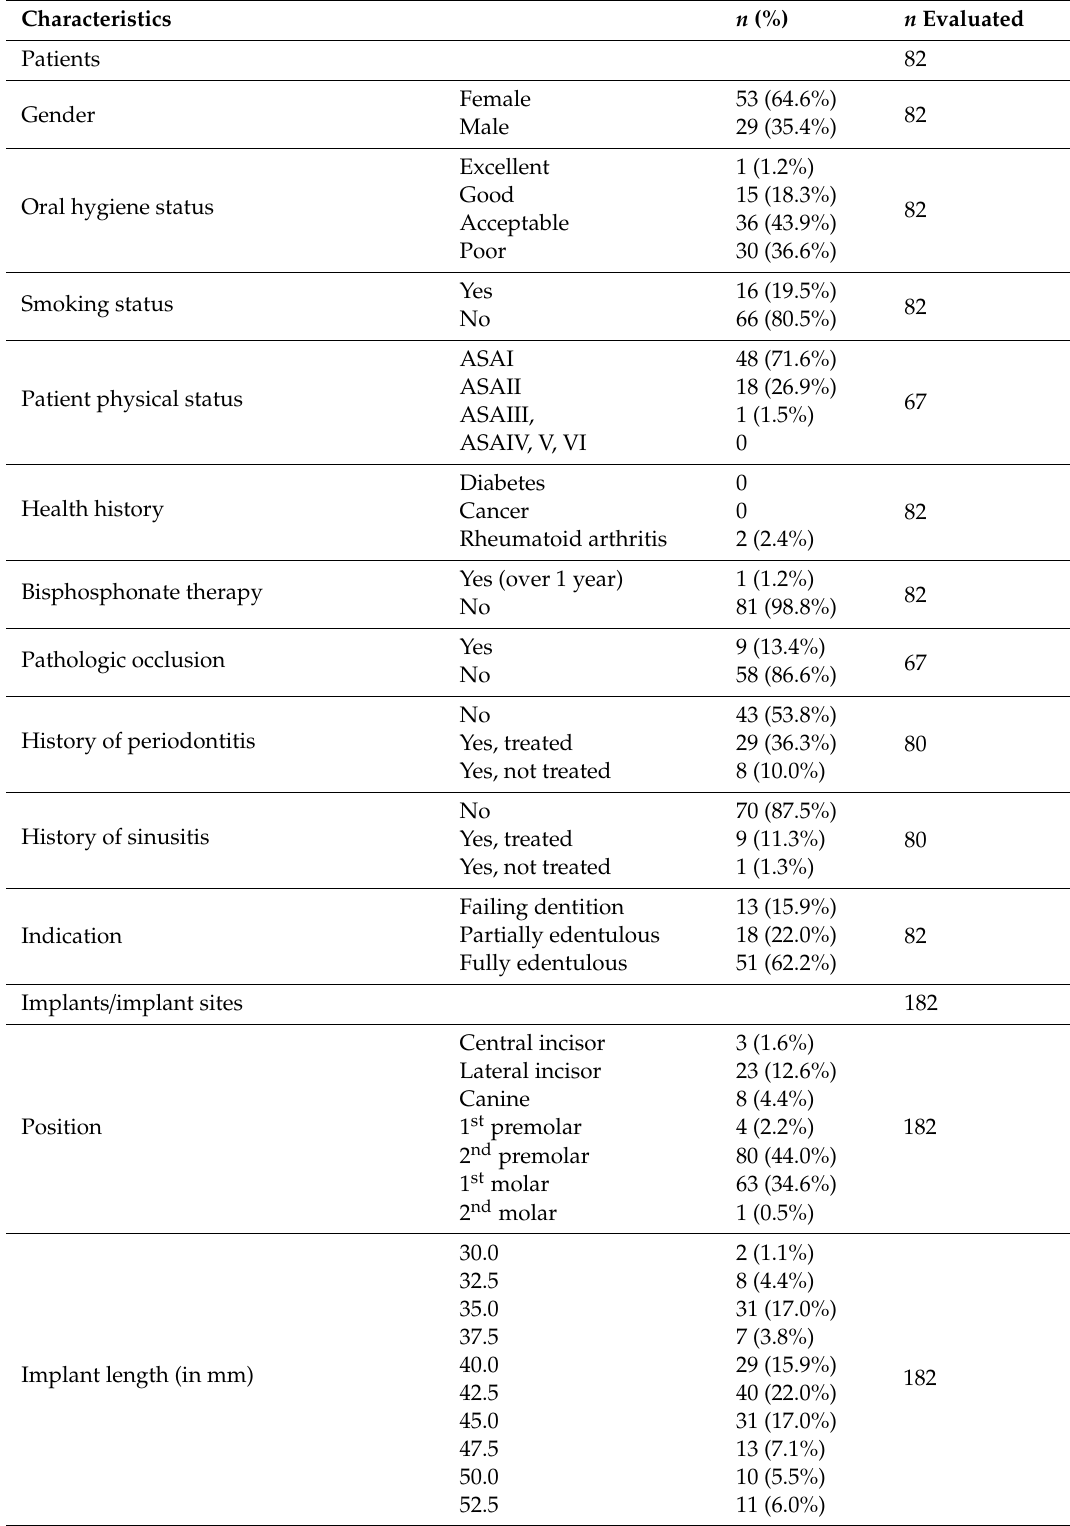
Table 1. Baseline